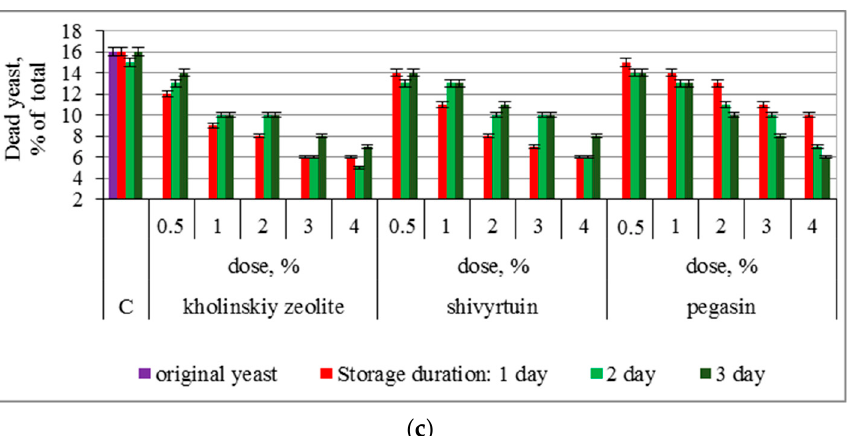
Figure 2. Changes in the physiological parameters of yeast culture stored in beer wort with natural ZT (C—control sample, 0.5–4% values—dose of zeolite-containing tuffs): ( a ) the number of yeast cells with glycogen; ( b ) the number of budding yeast cells; ( c ) the number of dead yeast cells; ( p ≤ 0.05). Compared to the experimental series with beer wort, the physiological parameters of the microbial culture stored under a layer of young beer in the presence of ZT demon- strated a similar trend, but at a lower manifestation rate (Figure 3).